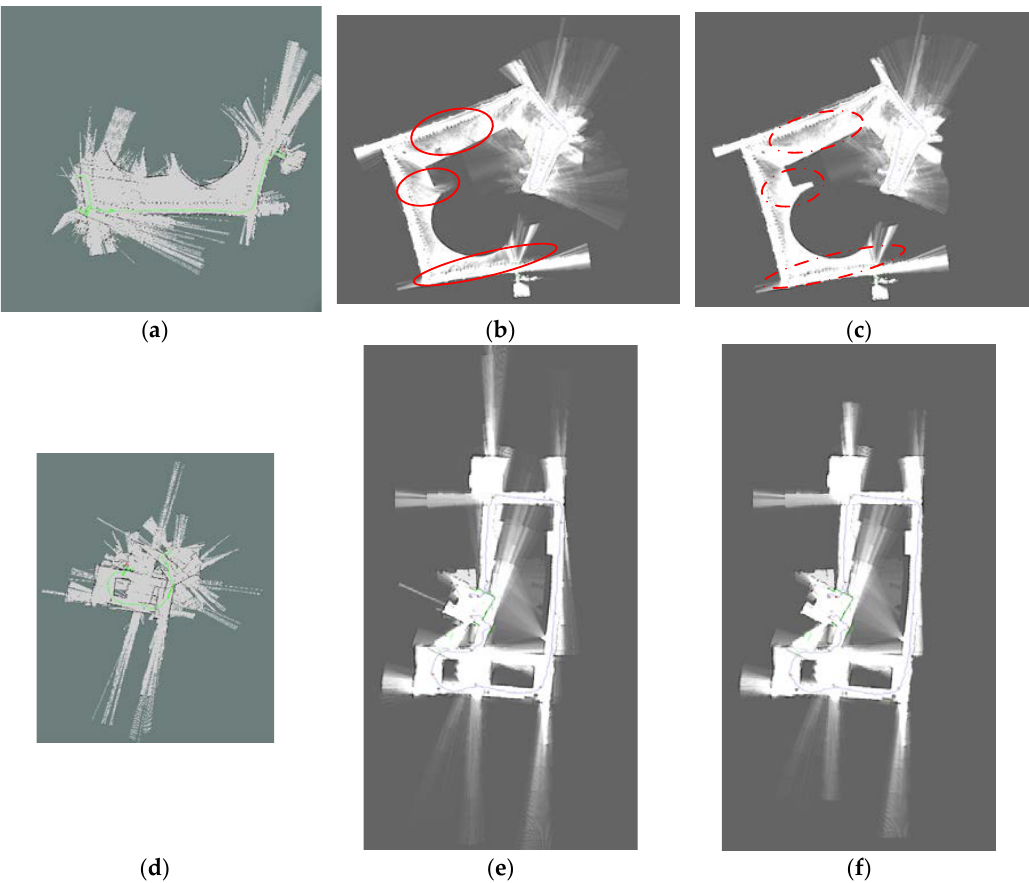
Figure 15. Evaluation results with HectorSLAM, Cartographer (LiDAR only) and the proposed method. The first raw is the generated maps with “Team_Hector_MappingBox_Dagstuhl_Neubau.bag” file. They are ( a ) HectorSLAM; ( b ) Cartographer (LiDAR only); ( c ) the proposed method respectively. The second raw is the generated maps with “Team_Hector_MappingBox_L101_Building.bag” file. They are ( d ) HectorSLAM; ( e ) Cartographer (LiDAR only); ( f ) the proposed method